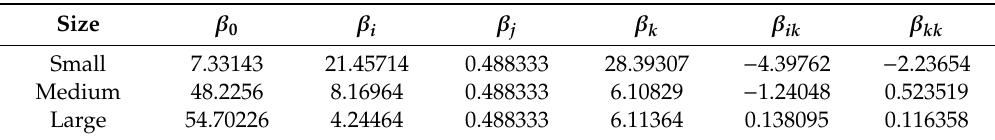
Table 3. Regression coe ffi cients ( β ) for peeled surface area (PSA) of small, medium and large cassava tubers after enzymatic treatment and mechanically